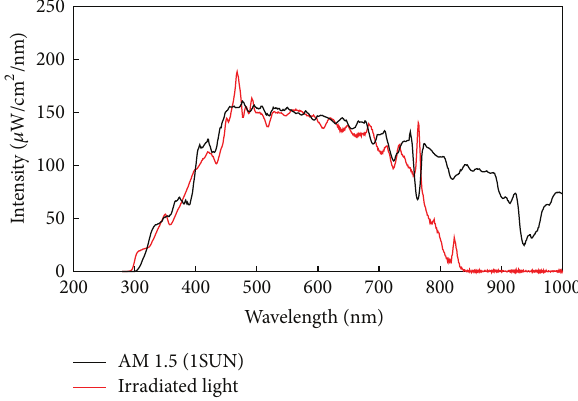
Figure 2: Spectrum of irradiated light (comparison with AM